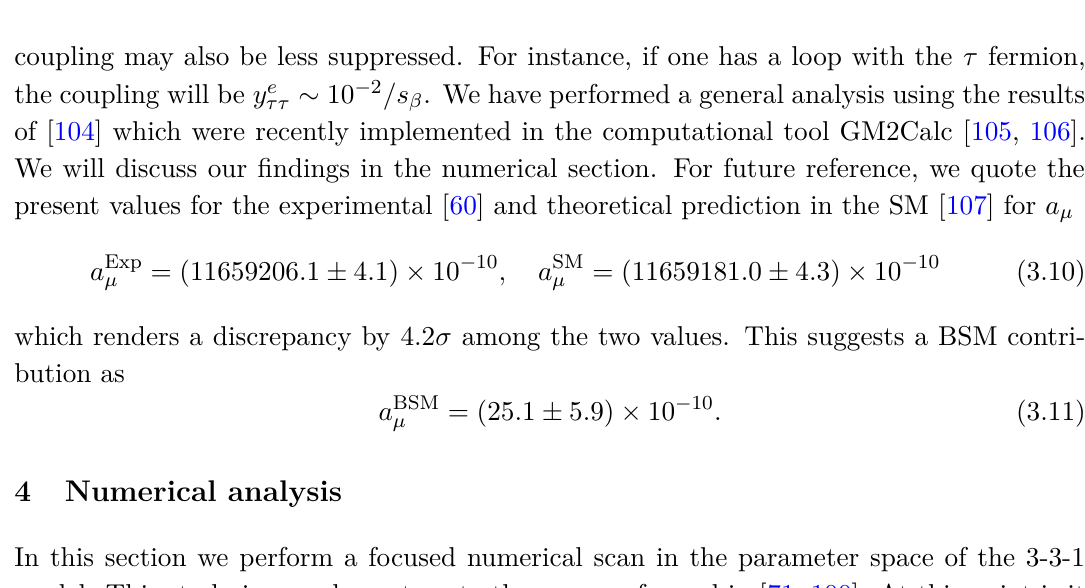
Table 1 . Input parameter